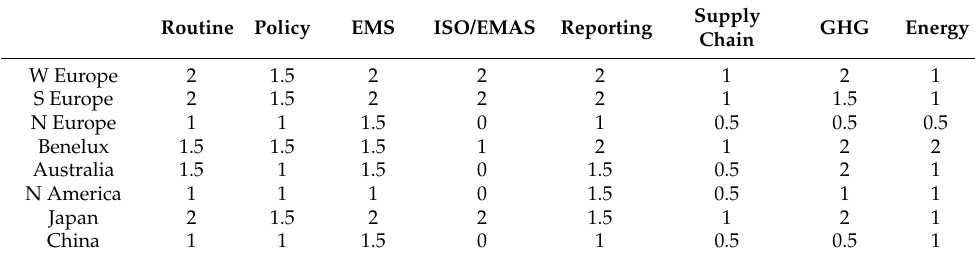
Table 6. Partial grades’ medians among